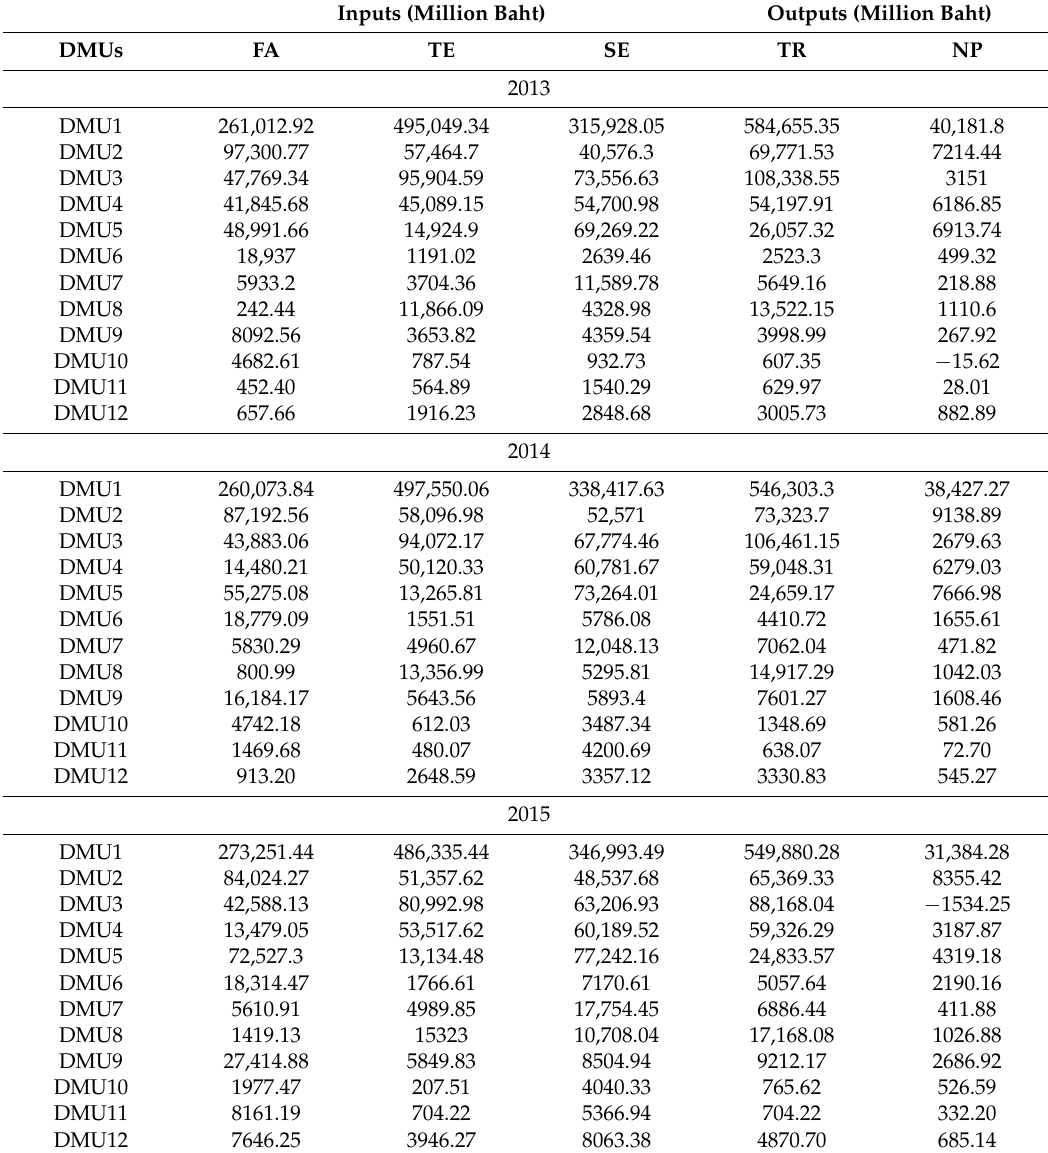
Table 6. The financial results of energy companies in